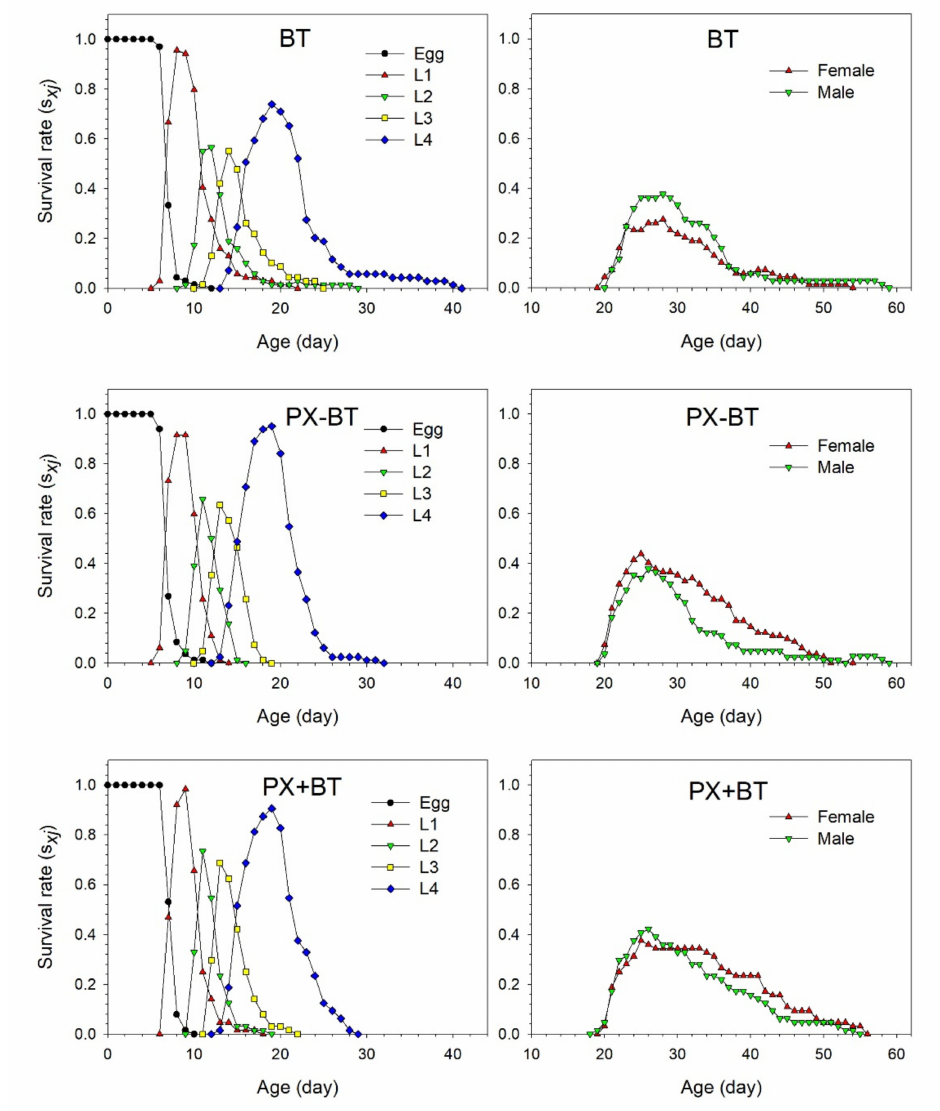
Figure 2. Age-stage specific survival rate ( s xj ) of Bemisia tabaci when feeding on Chinese kale alone (BT), with prior Plutella xylostella damage (PX − BT) or with simultaneous P. xylostella damage (PX +